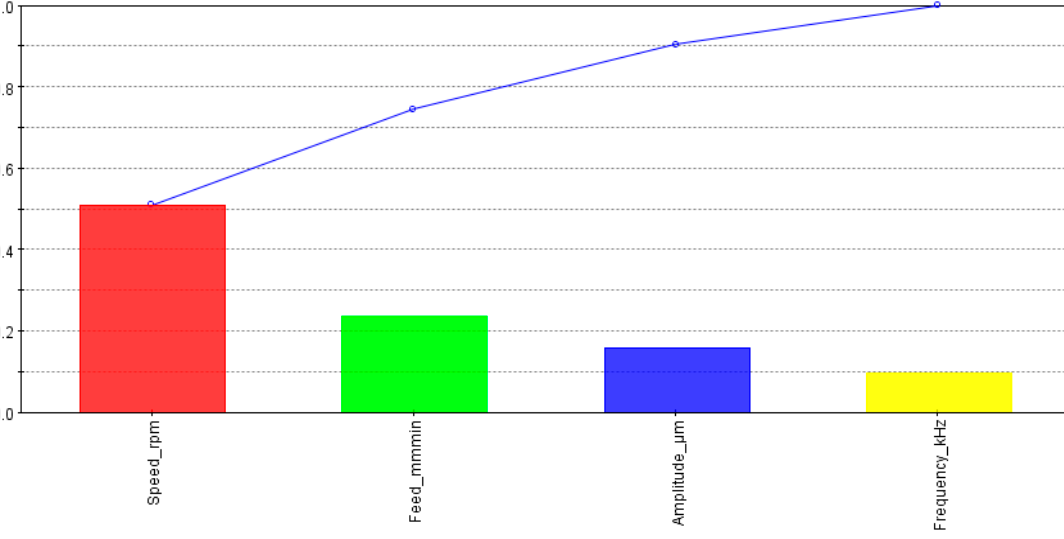
Figure 9. E ff ects of input parameters on cylindricity. Figure 9. Effects of input parameters on cylindricity. Figure 9. Effects of input parameters on cylindricity.